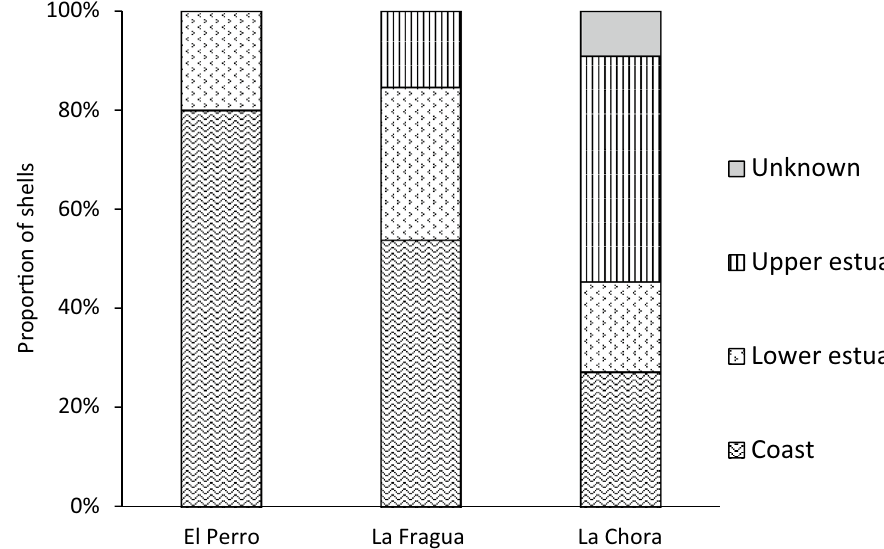
Figure 2. Provenance of the archaeological shells reconstructed using the oxygen and carbon stable isotope correlation obtained by sequential shell sub-sampling.